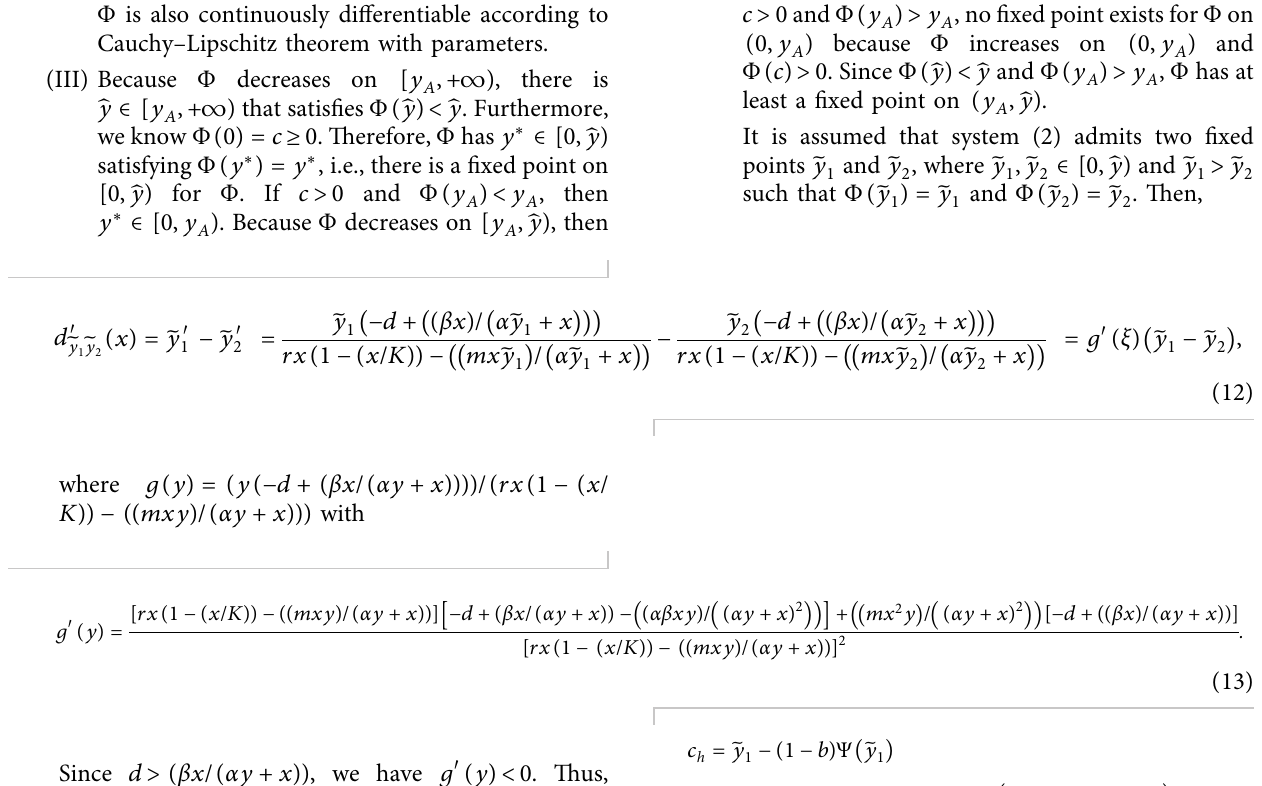
Figure 2: The relationship between Φ and y + (a) c � 10, and (b) c �